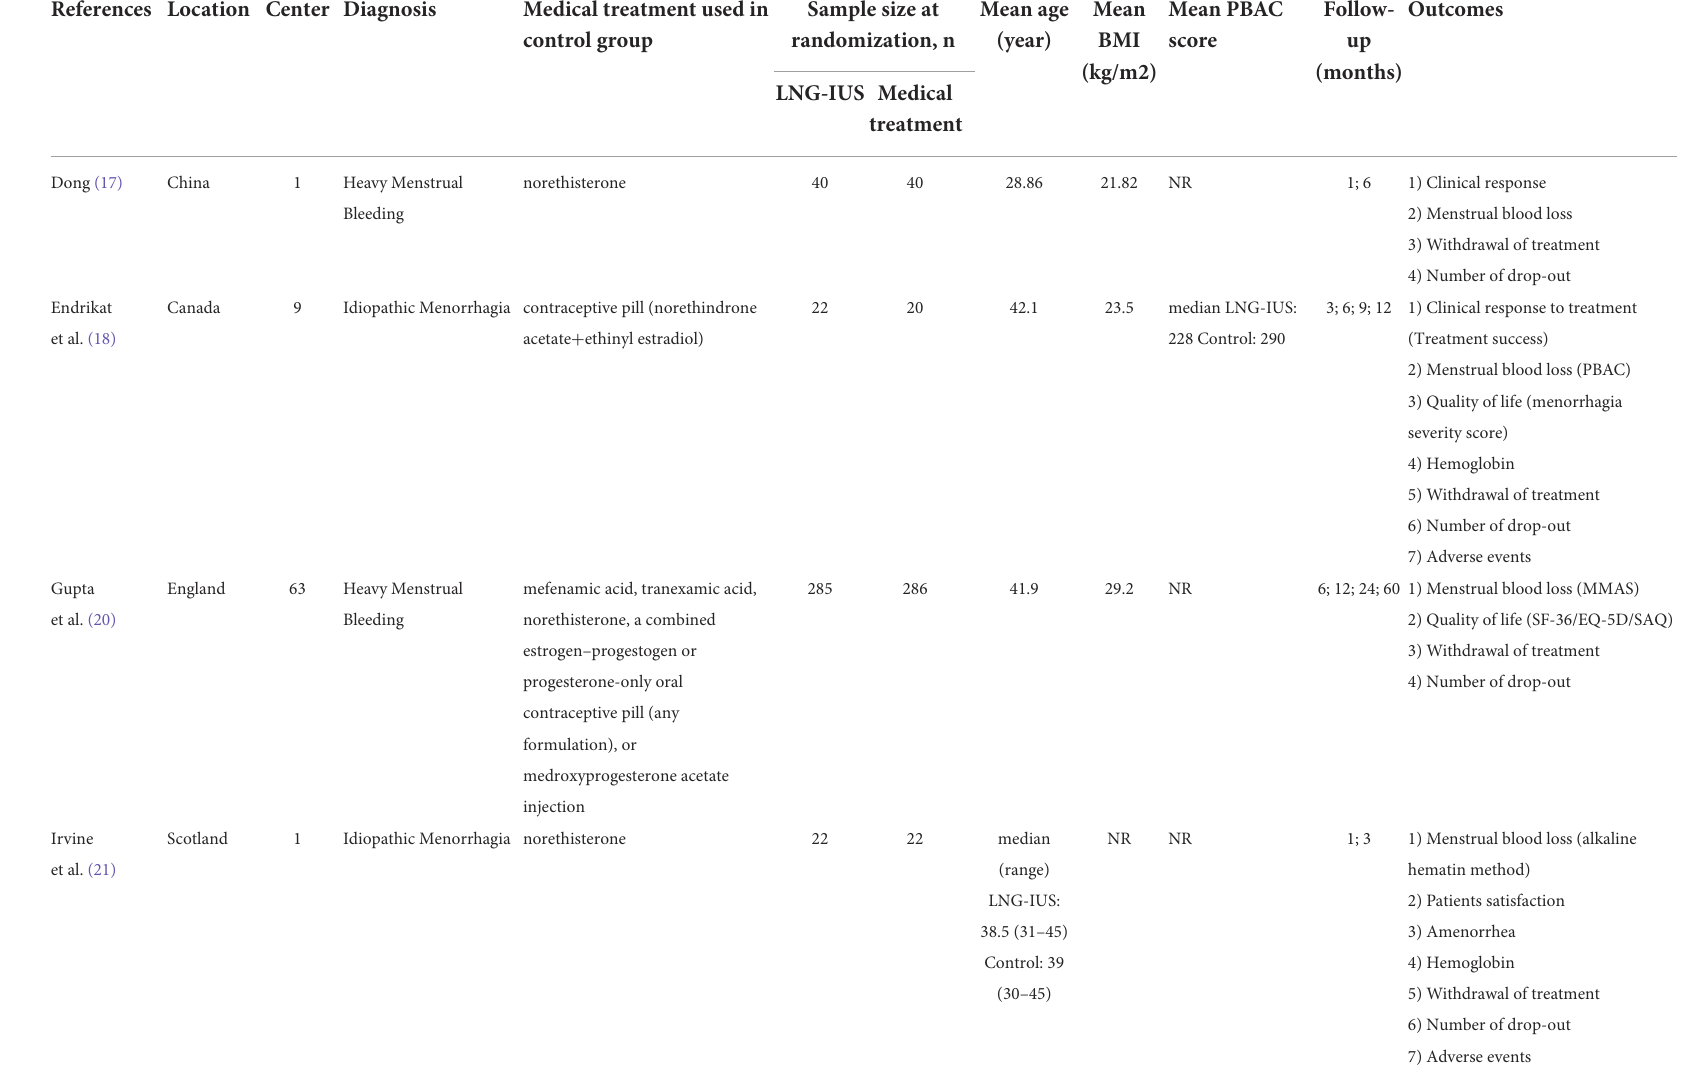
TABLE 1 Characteristics of included